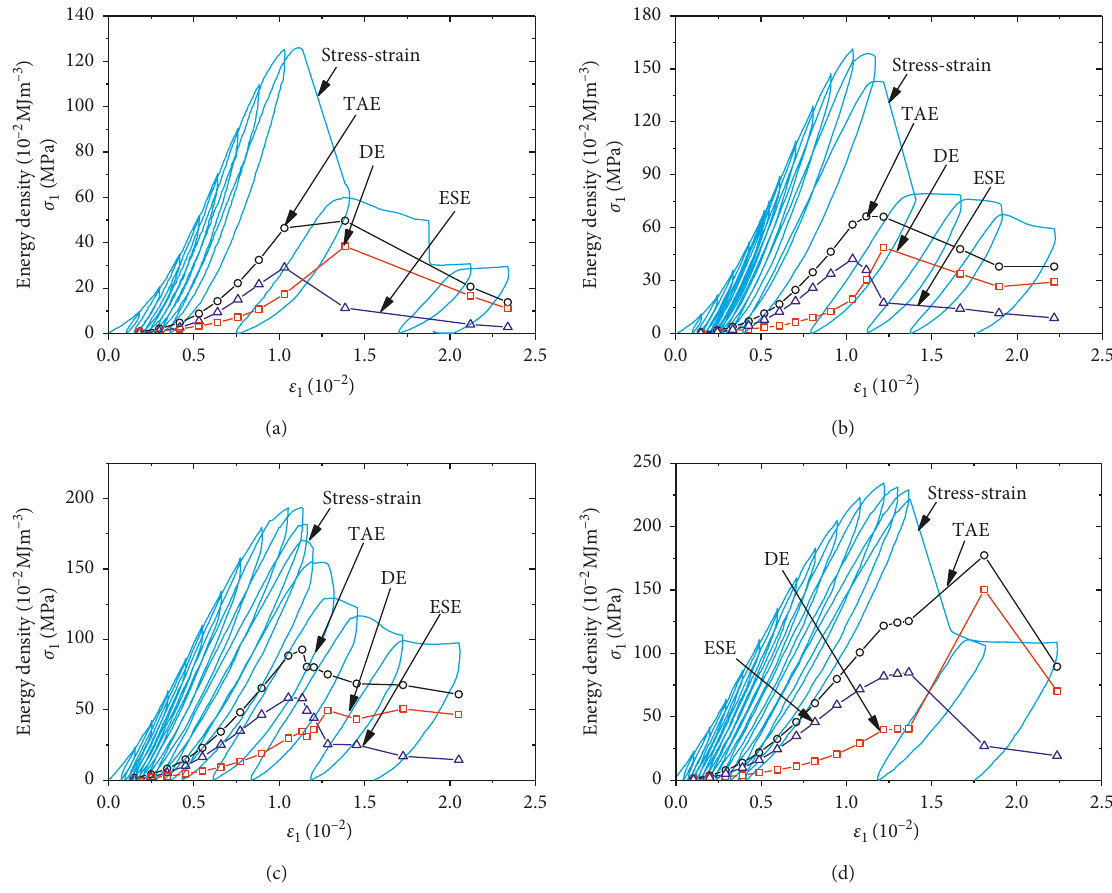
Figure 6: Energy evolution curves during the cyclic loading-unloading triaxial compression tests with confining pressures of 5MPa (a), 10MPa (b), 20 MPa (c), and 30MPa